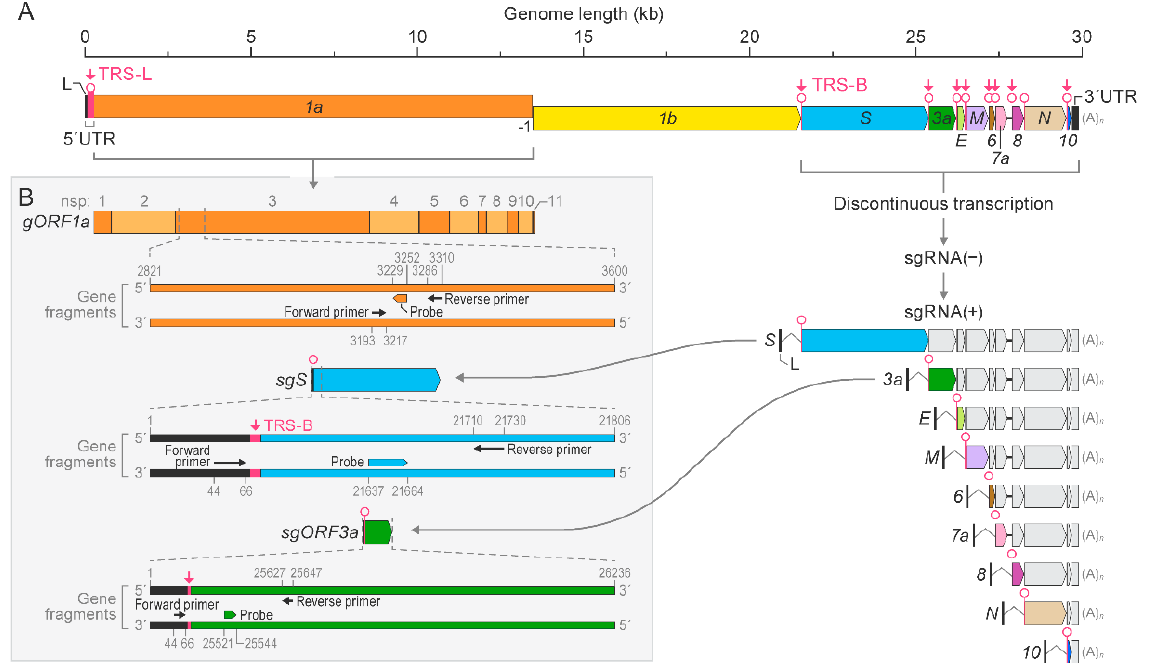
Figure 3. Schematic of SARS-CoV-2 genome organization and transcription. SARS-CoV-2 genomic RNA ( gORF1a and gORF1b ) and subgenomic RNA ( sgRNA ) structure (comprising S , spike; E , enve- lope; M , membrane; and N , nucleocapsid) with 5 ′ leader sequence and transcriptional regulatory sequences (TRS-L and TRS-B) ( A ). The negative-sense and positive-sense sgRNA —sgRNA ( − ) and sgRNA (+), respectively—arising from discontinuous transcription and the primer and probe binding regions for gORF1a , sgS , and sgORF3a gene fragments are illustrated ( B ). SARS-CoV-2 = severe acute respiratory syndrome coronavirus 2.